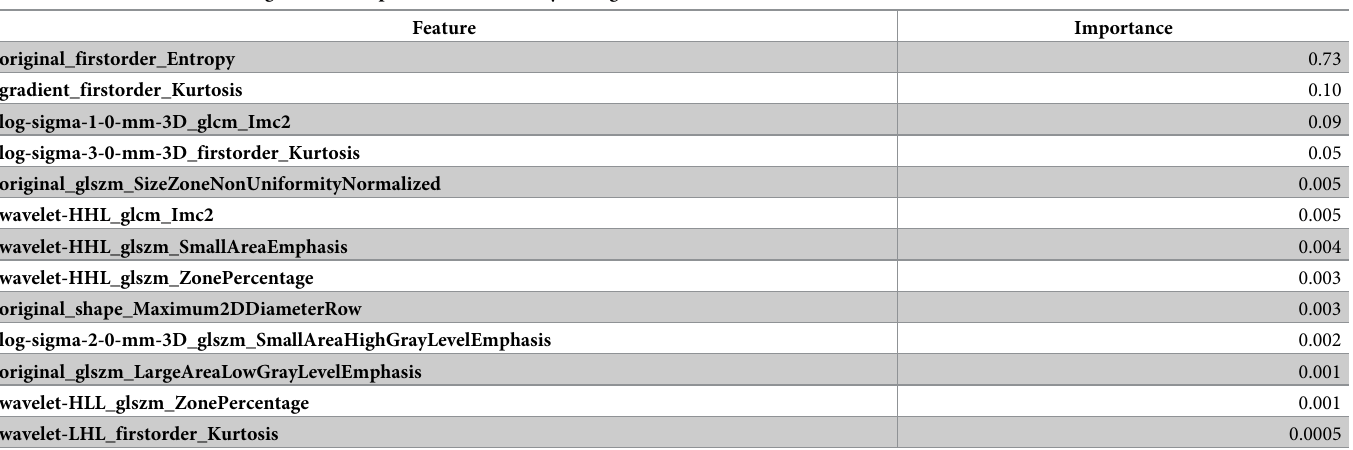
Table 3. Radiomic features alongside their importance as ranked by the algorithm.